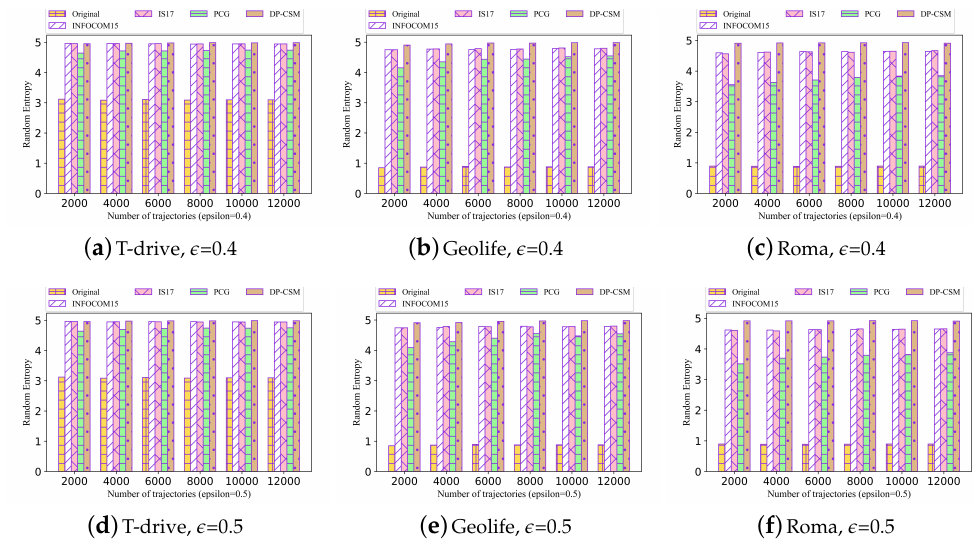
Figure 7. Random entropy comparison of the four models under different settings. In particular, we fix k = 80 and vary the privacy budget (cid:101) and the size of trajectory datasets. For the privacy budget, we choose two kinds of values, i.e., (cid:101) = 0.4 and (cid:101) = 0.5, respectively. Under each privacy budget, we vary the sizes of trajectory